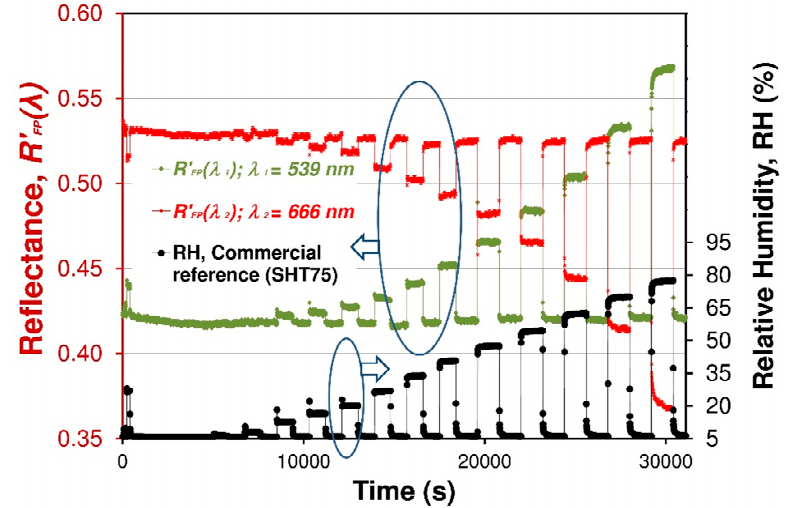
Figure 12. Normalized reflectance signals ( R FP ’( λ )) (at λ 1 = 539 nm—green and λ 2 = 666 nm—red) vs. time of the FPI sensor. For comparison, those raw measured optical signals are presented with response of a commercial SHT75 sensor (black line).